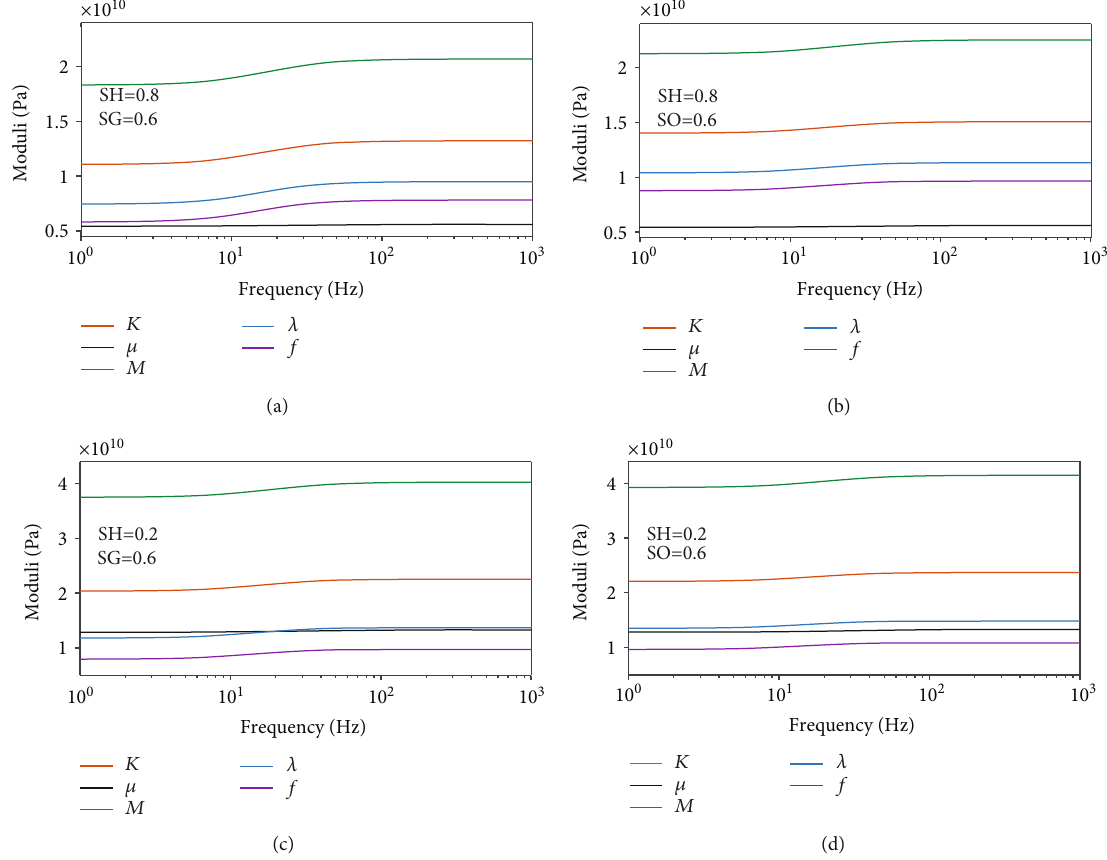
Figure 1: Dispersion analysis of di ff erent elastic parameters. SH indicates shale content, SH = 0 : 2 corresponds to sandstone reservoir and SH = 0 : 8 corresponds to shale reservoir; SG indicates gas saturation in gas-water mixed fl uid and SO indicates oil saturation in oil-water mixed fl uid; K , μ , M , λ , and f indicate the bulk modulus, shear modulus, P-wave modulus, Lamé parameter, and Russell fl uid factor, respectively; the value of γ 2 dry is given as 2.3. (a) Gas-bearing shale reservoir; (b) oil-bearing shale reservoir; (c) gas-bearing sandstone reservoir; (d) oil-bearing sandstone